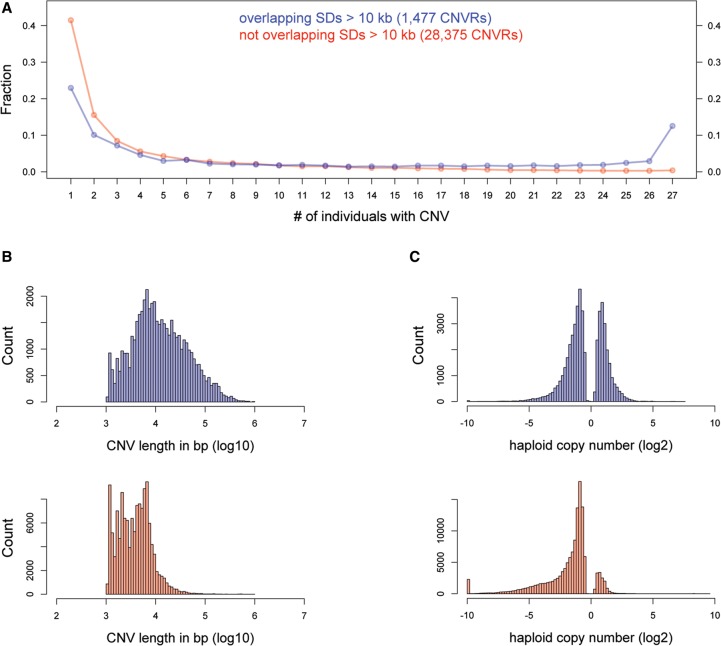
CNVRs that overlap with large SDs are present in multiple individuals. Overlapping calls from all individuals were merged into CNVRs and analyzed separately based on their intersection with SDs >10 kb. The number of individuals with CNV calls within each CNVR was counted (A). In total, we identified 1477 unique CNVRs that overlapped with SDs (blue) and 28,375 CNVRs that did not overlap with SDs (red). The graph shows the frequencies of CNVR presence across all samples. The length (B) and copy number (C) distributions of CNVs that overlap with genes differ significantly between the two data sets (KS test, P < 2.2 × 10−16). In the histograms shown in C, the bin with −10 values corresponds to events with absolute deletion; to ensure that all data were log2-transformable, these values were converted to a value of 0.001.